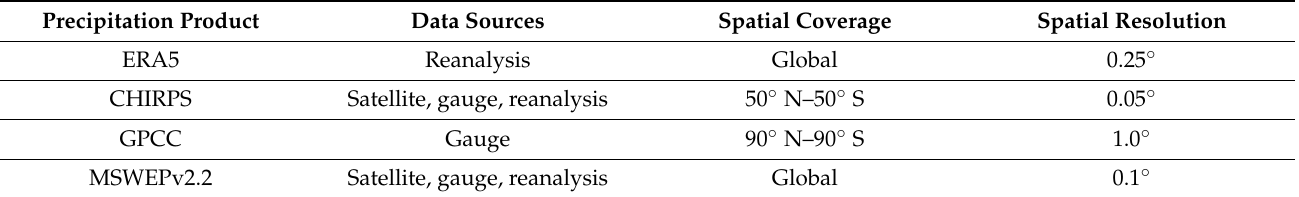
Table 1. Precipitation products evaluated in this study.